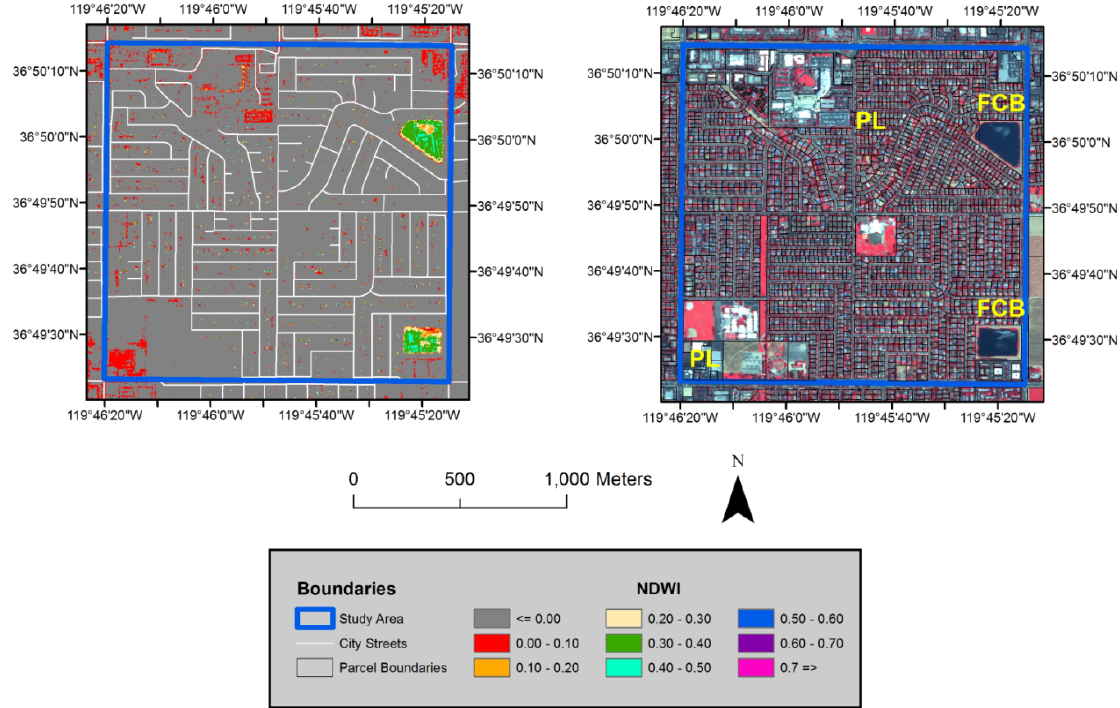
Figure 2. Color-coded Normalized Difference Water Index ( NDWI) image of the study area ( left ). QuickBird image (copyright 2013) showing the near infrared (NIR), red, and green false color composite of the study area ( right ). Parking lots (PL), which have asphalt surfaces, show lower NDWI values, while flood control basins (FCB), which have water surfaces, show higher NDWI values. Vegetation, and other non-water surfaces, such as rooftops (excluding asphalt), have NDWI values equal to, or below, zero and are color-coded